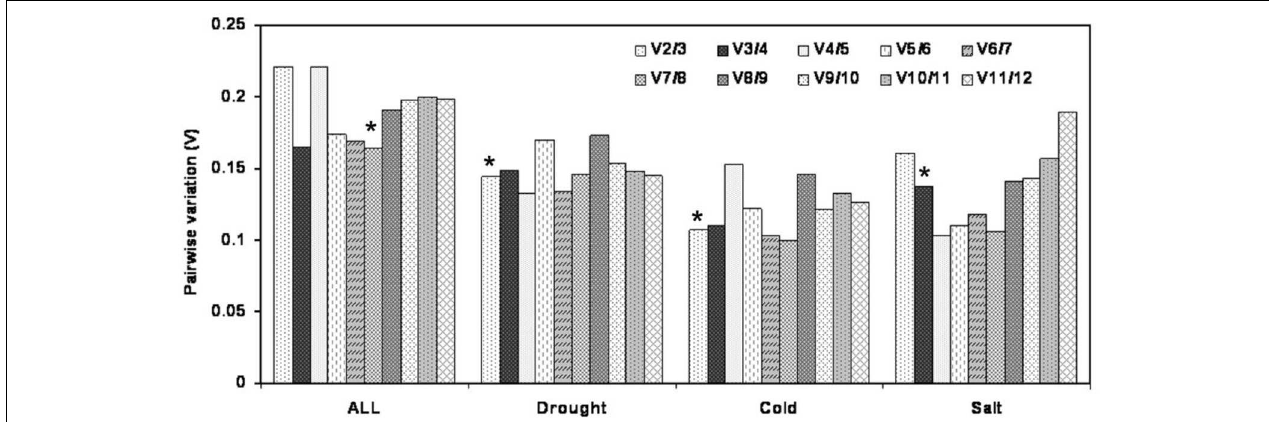
TABLE 3 | Expression stability of the candidate reference genes calculated by NormFinder. Rank